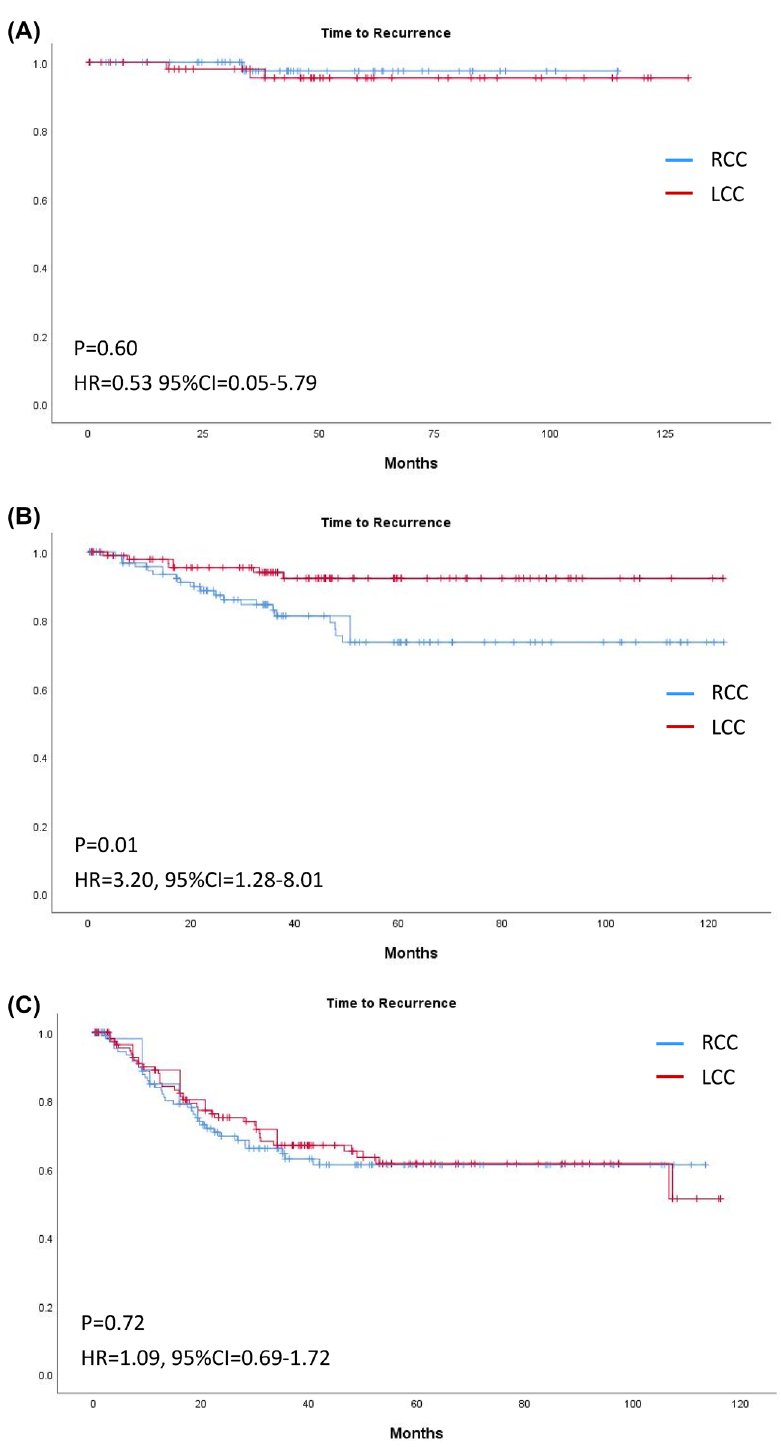
Figure 7. Kaplan–Meier curves of time to recurrence of right-sided and left-sided colon cancer in ( A ) Stage I, ( B ) Stage II, and ( C ) Stage III after